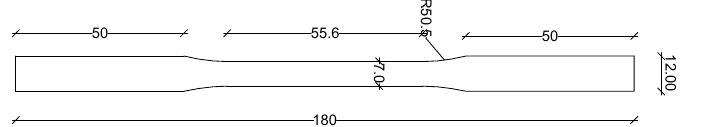
Figure 3. Specimen dimensions (mm).